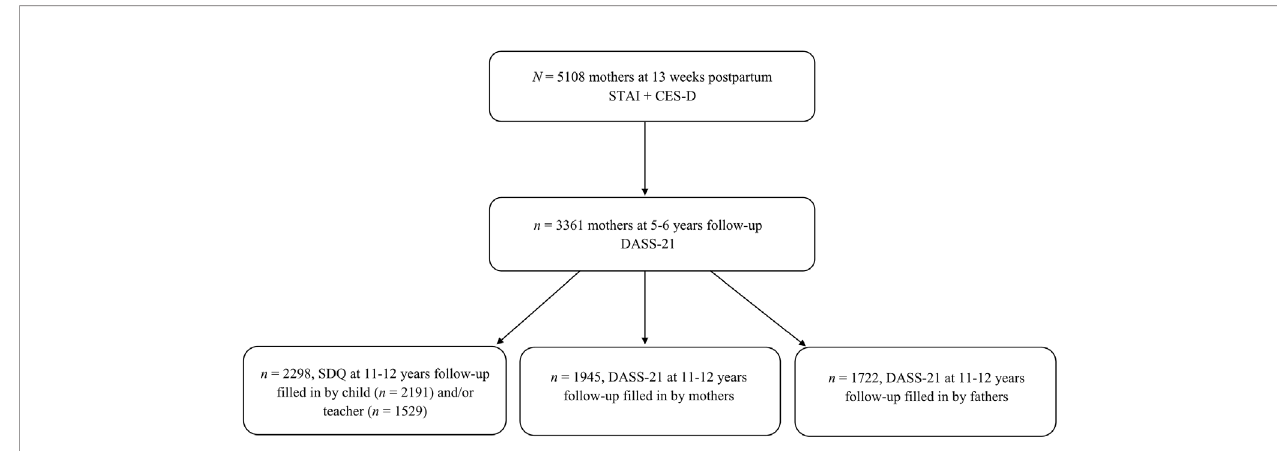
FIGURE 1 | Flowchart of the study population. STAI, State-Trait Anxiety Inventory; CES-D, Center for Epidemiologic Studies Depression Scale; SDQ, Strength and Dif fi culties Questionnaire; DASS-21, Depression Anxiety Stress